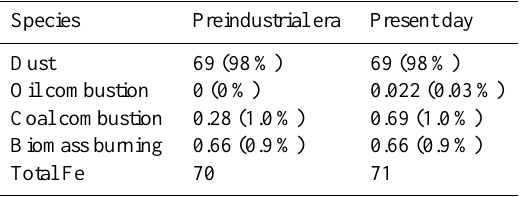
Table 2. Global Fe emission (TgFeyr − 1 ) estimated for different types of Fe-containing